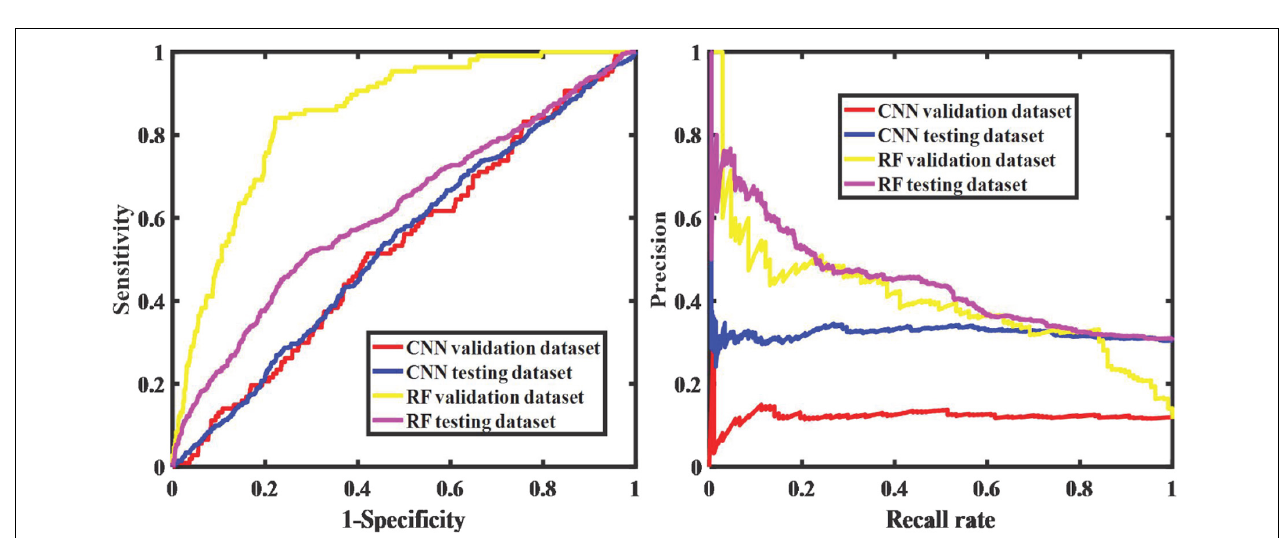
FIGURE 10 | The performance for evaluating the color of the iris (CNN).